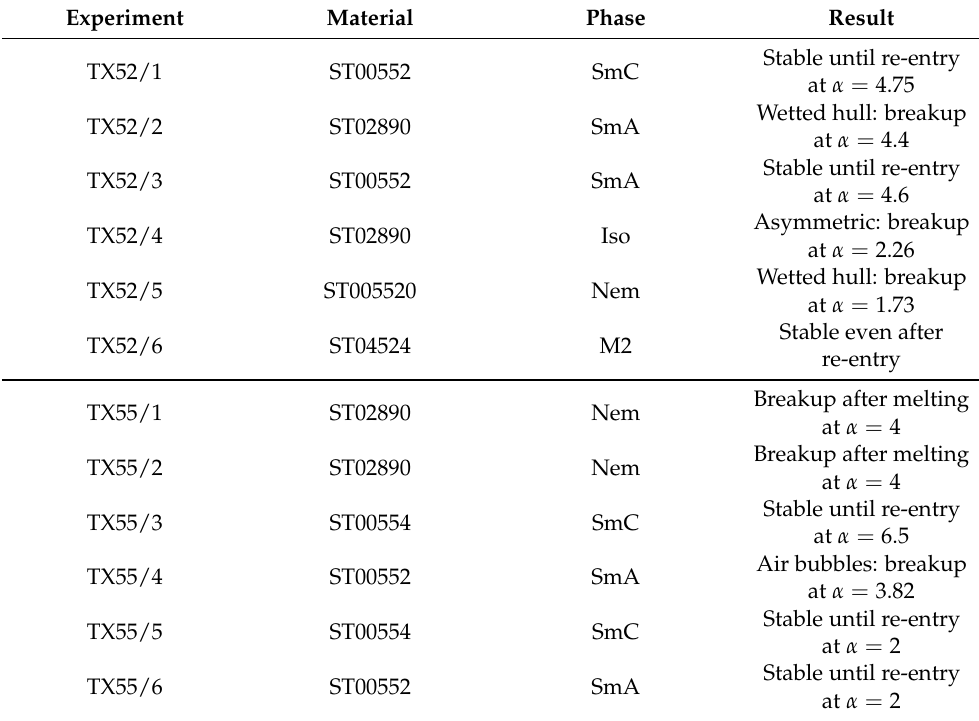
Table 3. A summary of the outcomes of the